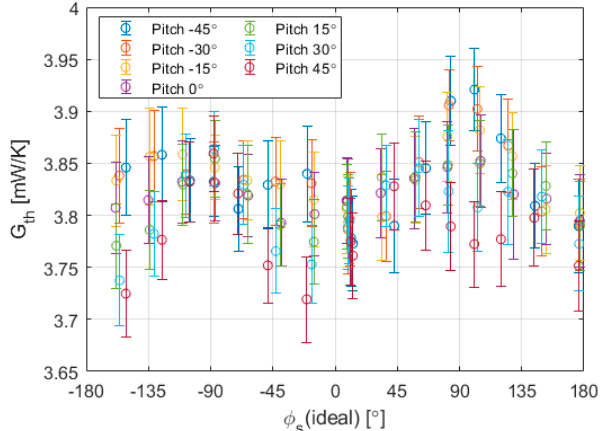
Figure 18. Estimation of the global convective heat transfer coefficient for the Aarhus experiment reported in Figures 11 and 12. The experiment was carried out at constant wind velocity of 5.6 m/s, 49 °C of temperature overheat and 10 mbar of pressure.